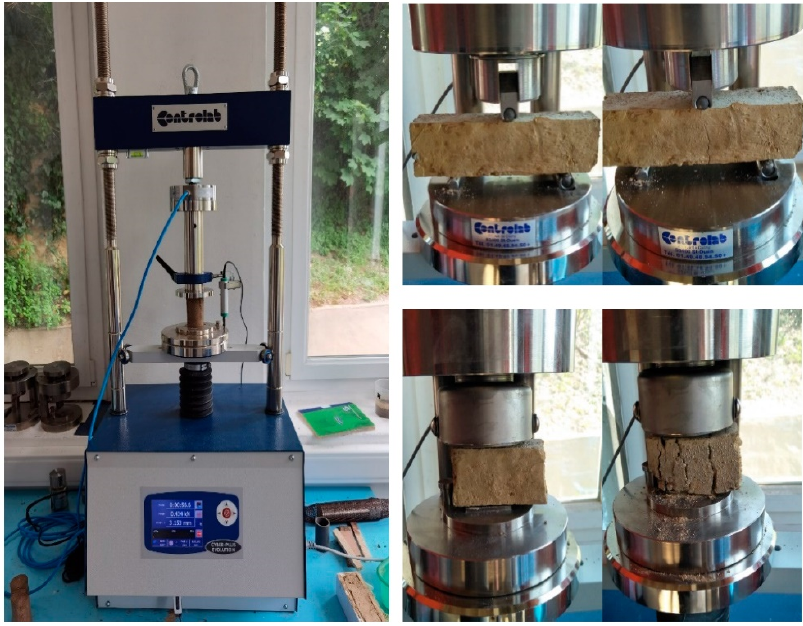
Figure 6. Press-machine ( left ), flexural test ( right top ), and compression test ( right bottom ).